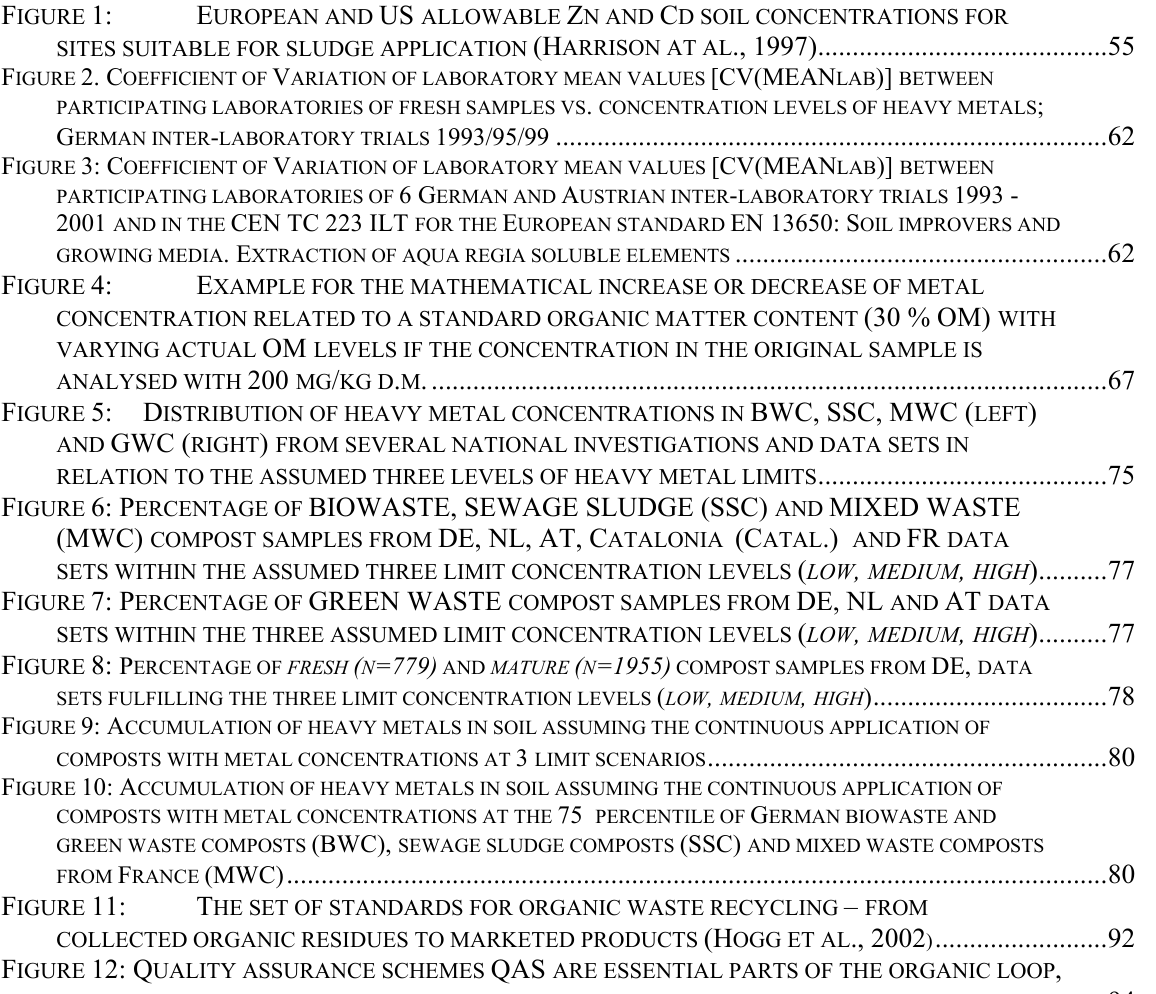
F IGURE 14: T HIS COMPOST (FLORATOP -B RAND ) PRESENTATION IN A SUPERMARKET CAN F IGURE 15: F IGURE 16: S IMPLE REGISTRATION REGIME E . G . WITH A NATIONAL FERTILISER ORDINANCE WITHOUT REGULAR 3 RD PARTY APPROVAL OF COMPOST PRODUCTION AND F IGURE 17: F IGURE 18: QAS – Q UALITY ASSURANCE AND CERTIFICATION SCHEMES FOR COMPOST IN F IGURE 19: P RODUCT CERTIFICATION SCHEME INCLUDING DOCUMENTATION , EXTERNAL INSPECTION AND SAMPLE TAKING BASED ON COMPREHENSIVE E ND OF W ASTE F IGURE 20: C OMPOST CERTIFICATION SCHEME INCLUDING FULL SCALE DOCUMENTATION , EXTERNAL INSPECTION AND SAMPLE TAKING BUT ALSO STRICT ELEMENTS APPLICATION